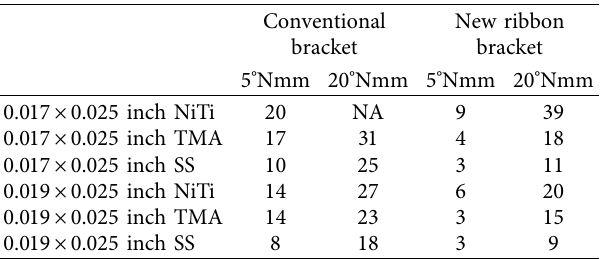
Table 4: Comparison of the moment and angle of rotation to reach 5–20Nmm for two different bracket